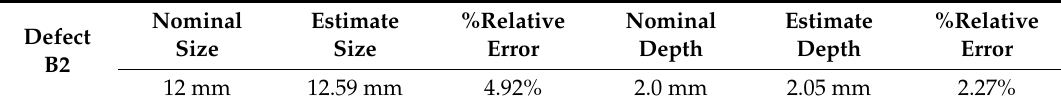
Figure 21. Calibration curve, (PPT amplitude, 0.3906 Hz with 512 frames). Table 5. Estimation error in evaluating the size and the depth of the defect with the amplitude algorithm (PPT).